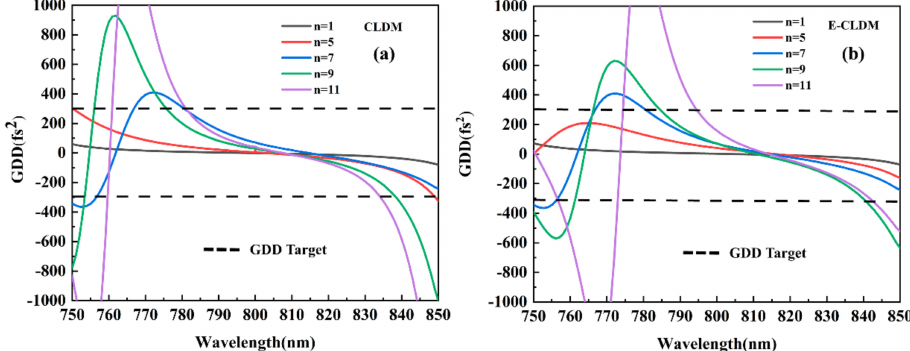
Figure 2. Dispersion for different numbers of protective layer periods. ( a ) CLDM, when n = 5, the maximum group delay dispersion (GDD) ripple is just under ± 300 fs 2 . When n > 5, the GDD ripple does not meet the requirements; ( b ) E-CLDM, when n = 5, the modified design has a superior dispersion value of ± 175 fs 2 , compared to the value of ± 300 fs 2 for the CLDM stack. However, for n > 5, the GDD ripple does not meet the